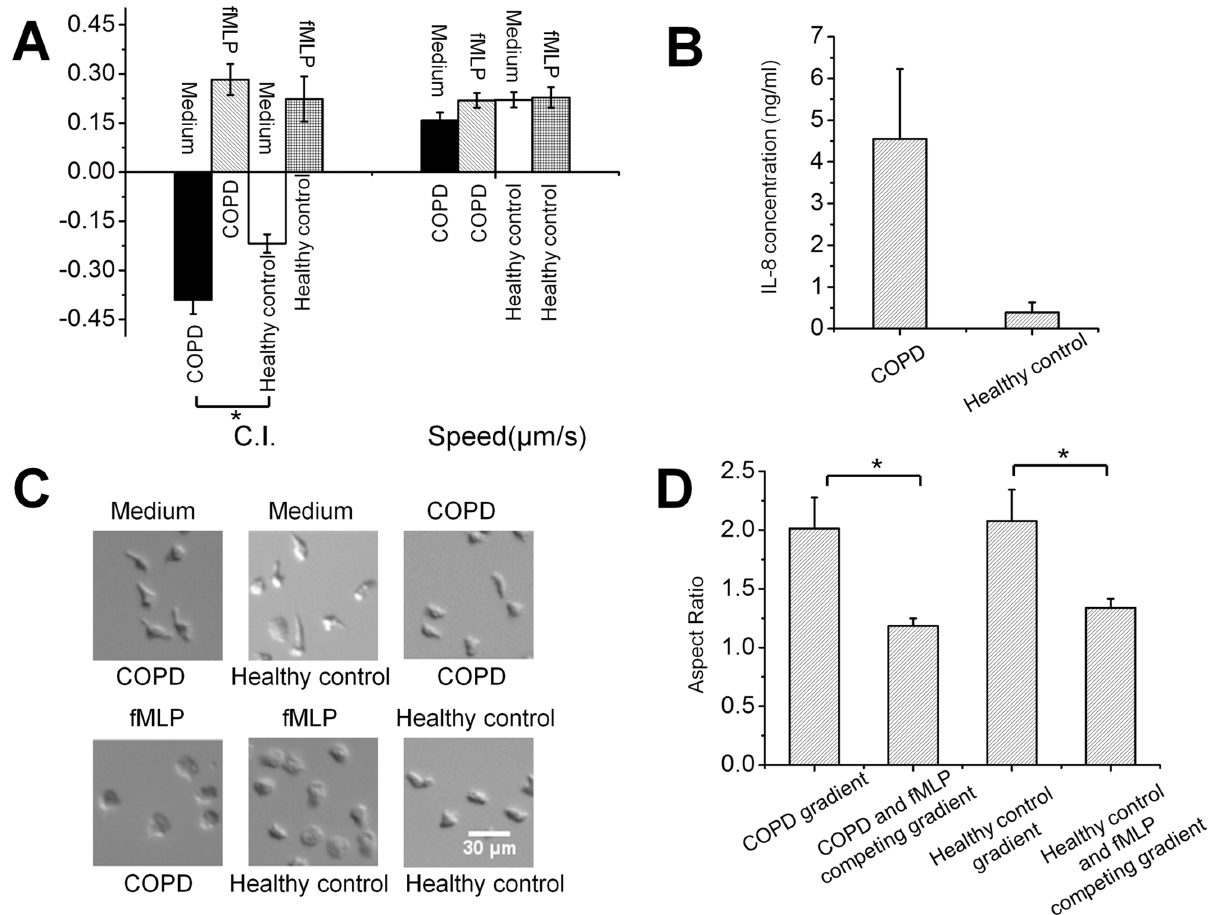
Fig 3. Neutrophil migration in different sputum (COPD or healthy control) and fMLP fields. (A) C.I. and migration speed in different sputum and fMLP fields; (B) IL-8 concentration in COPD sputum (n = 3) and healthy control sputum (n = 3); (C) Representative images of cell morphology in different sputum and fMLP fields. (D) Aspect ratio of cells in different sputum and fMLP gradients. Positive C.I. indicates cell migration towards the chemoattractant source labeled on the top; negative C.I. indicates cell migration towards the chemoattractant source labeled at the bottom.